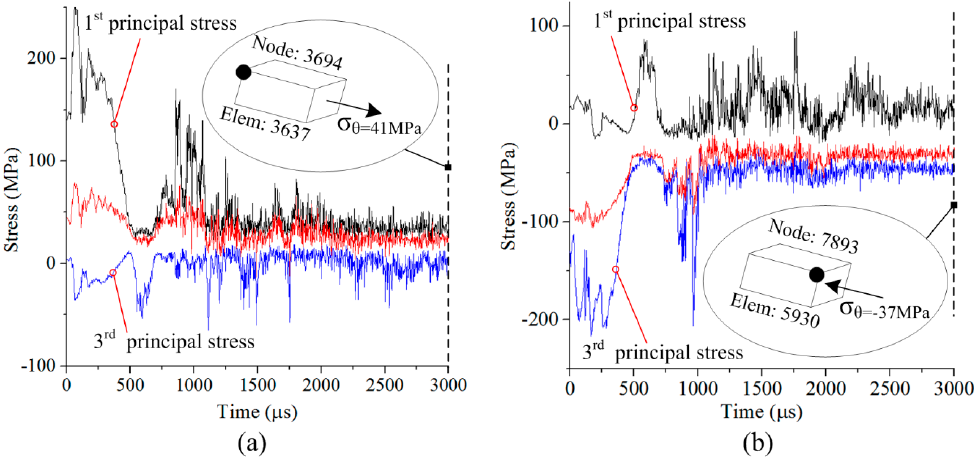
Figure 8. Stress changes at special nodes: ( a ) node 3694; ( b ) node 7893.